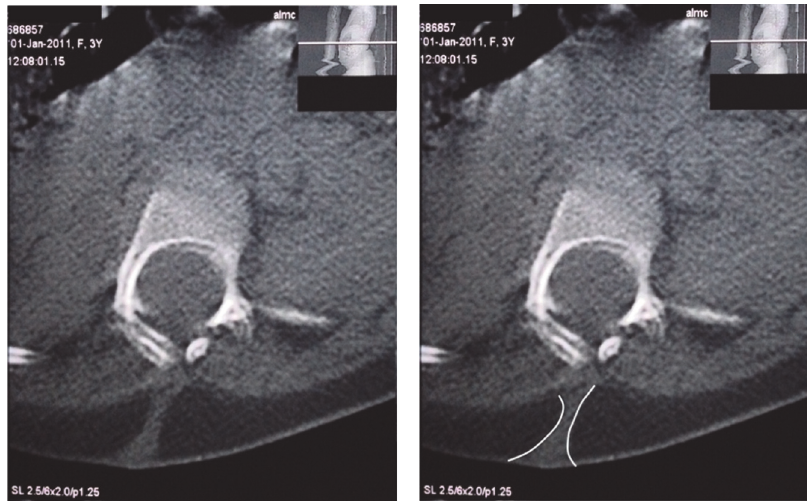
Figure 1: A transverse CT section demonstrating a dorsal dermal sinus connecting the epidermis to the epidural space.